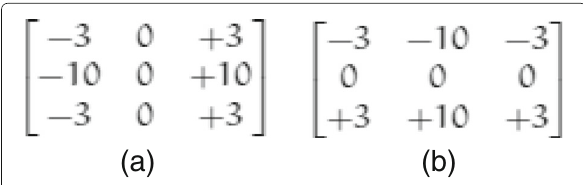
Fig. 2 Scharr a horizontal and b vertical masks for a 3 × 3 kernel